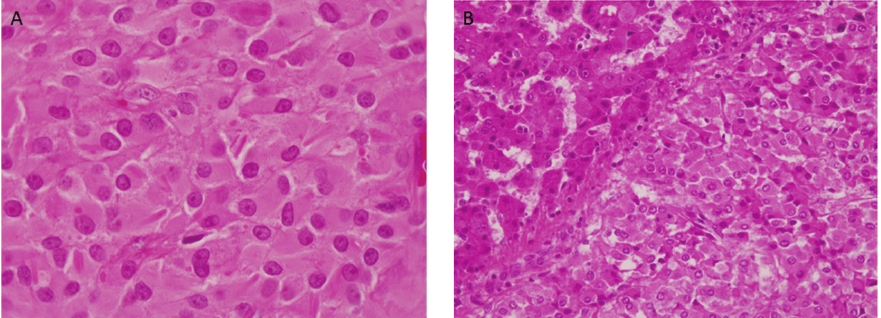
Figure 2: (A) High magnification photomicrograph of the testicular mass showing sheets of polygonal cells with abundant eosinophilic cytoplasm, distinct cell borders, and bland uniform nuclei with prominent nucleoli. Numerous Reinke crystals are present. (B) Photomicrograph of metastatic Leydig cell tumor (lower right) within the liver (upper